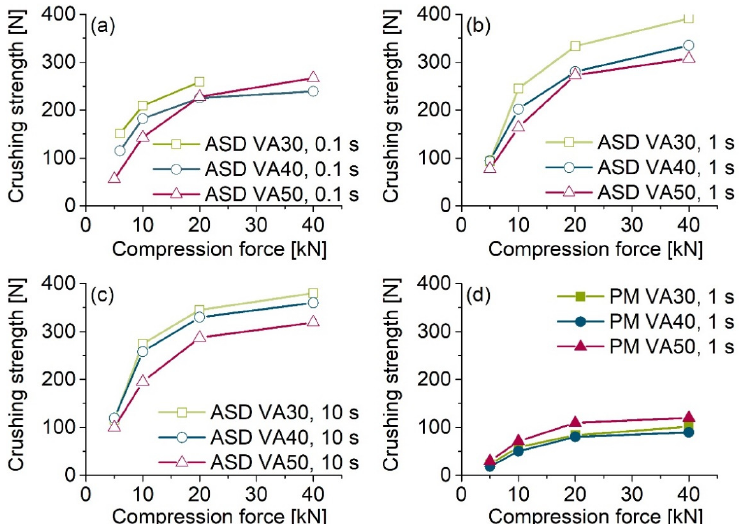
Figure 3. Crushing strengths of ASD and PM tablets with MCC 200 directly after preparation as a function of compression force. The ASD tablets were compressed with three different dwell times: ( a ) 0.1 s, ( b ) 1 s, ( c ) 10 s, and ( d ) PM tablets compressed with a dwell time of 1 s. Due to the small sample quantity, measurements were performed once per